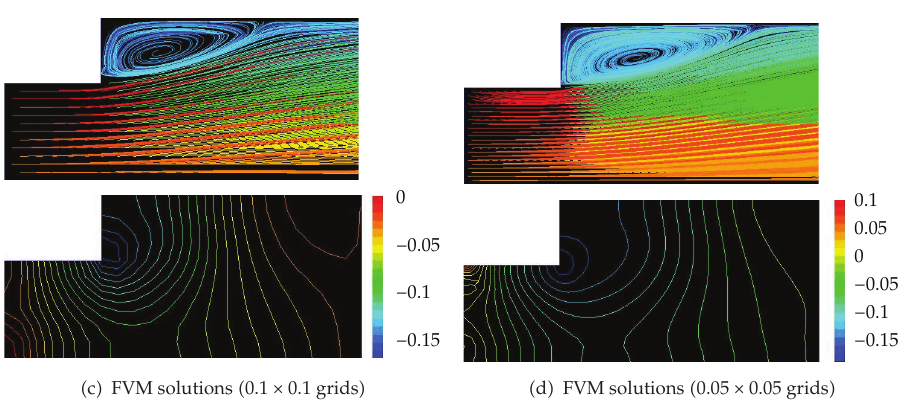
Figure 2: The streamline patterns and pressure distributions for flow field past a